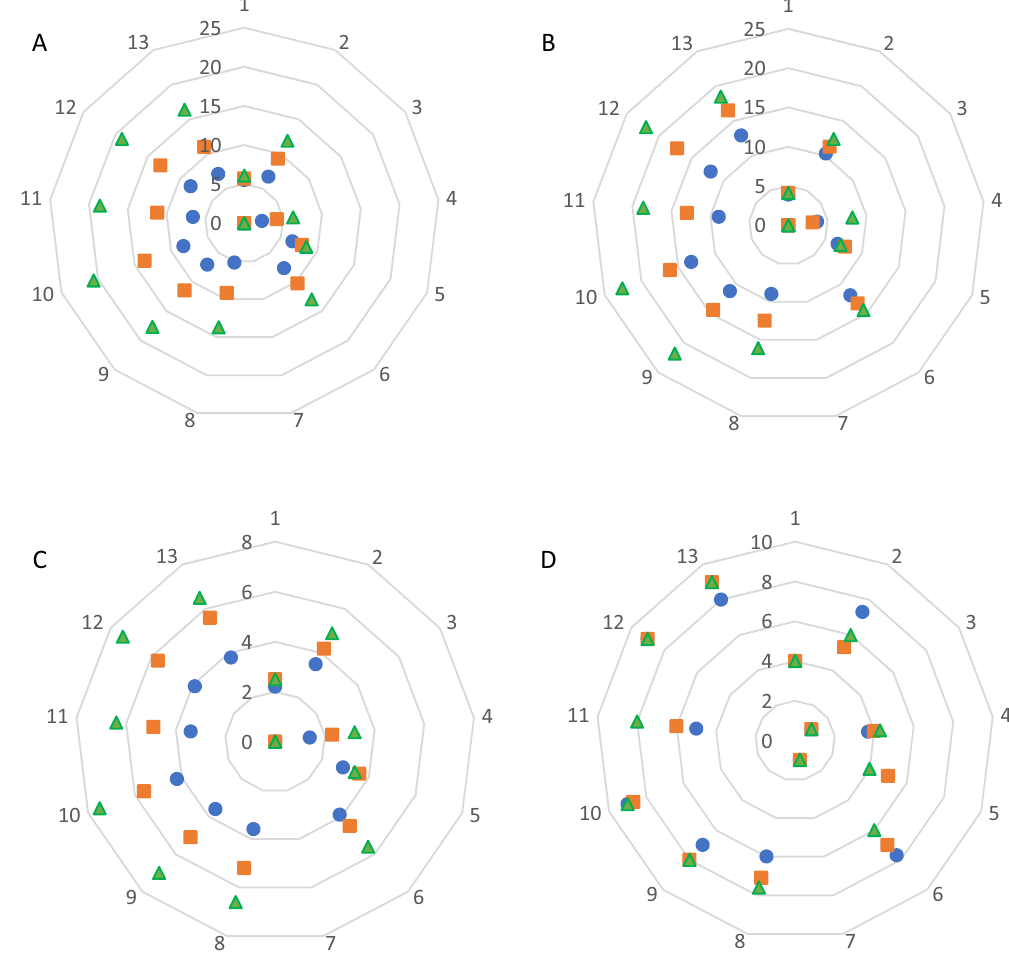
Figure 2. The effect of horticulture media on tomato plant parameters during vegetation. ( A ) Plant height (cm), ( B ) leaf lateral span (cm), ( C ) leaf number, ( D ) plant conditions (grade). Filled blue circle: two weeks. Filled orange square: three weeks. Filled green triangle: four weeks. 1-WC, 2-WC:SM, 3-WN, 4-WN:SM, 5-WPG, 6-WPG:SM, 7 WPGN, 8-WPGN:SM, 9-WPGN + WC(1), 10- WPGN + WC(1):SM, 11- WPGN + WC(2), 12-WPGN + WC(2):SM,